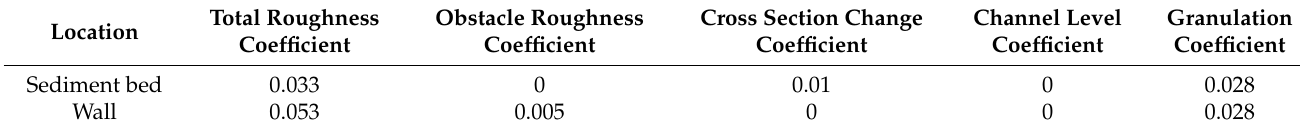
Table 11. Effective parameters in the calibration.